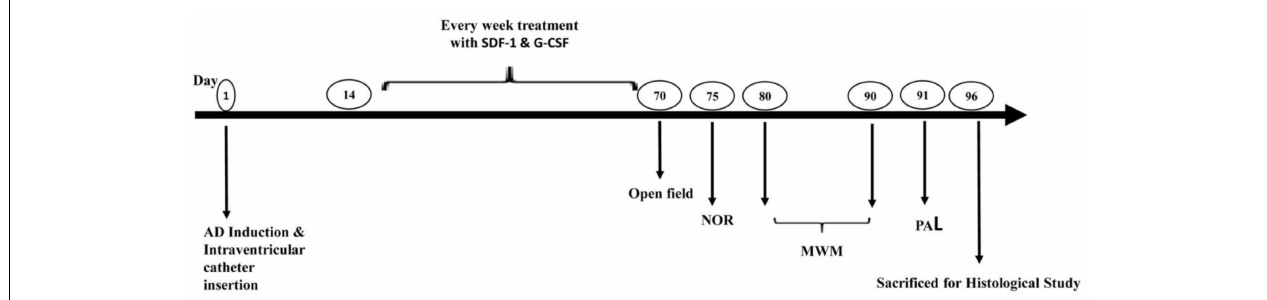
FIGURE 1 | Study design diagram. Alzheimer’s was induced in the rat model of Alzheimer’s disease by ICV injection of A β . The administration of SDF-1 and G-CSF was performed every week for 2 months after the injections of A β . Finally, behavioral studies (Open field, NOR Test, MWM, and PAL test) were performed and brain tissues were studied